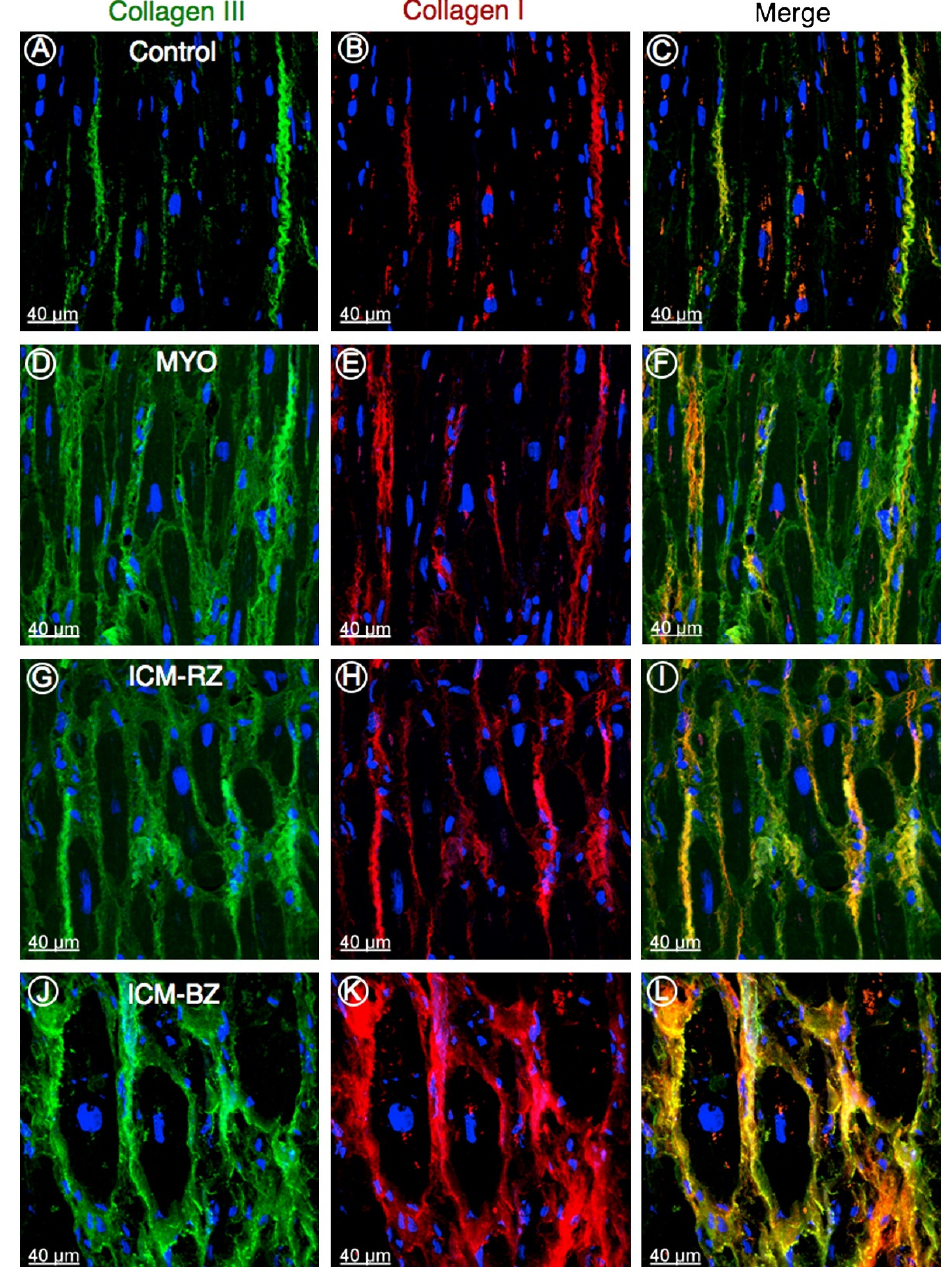
Figure 6. Representative confocal images of collagen type III (green) and type I (red) in control ( A – C ), in explanted human heart tissue samples from patients with inflammatory cardiomyopathy (MYO; D – F ), from patients with ischemic cardio- myopathy (ICM) from the remote zone (ICM-RZ; G – I ) and border zone regions (ICM-BZ; J – L ), demonstrating an increased accumulation of fibrillar collagens in diseased myocardium. Nuclei are stained blue with 4 ′ ,6-diamidino-2-phenylindole [105]